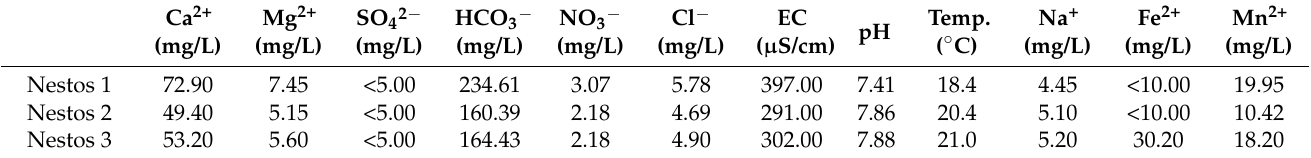
Table 7. Data of the major chemical constituents from the Nestos River (May 2019).